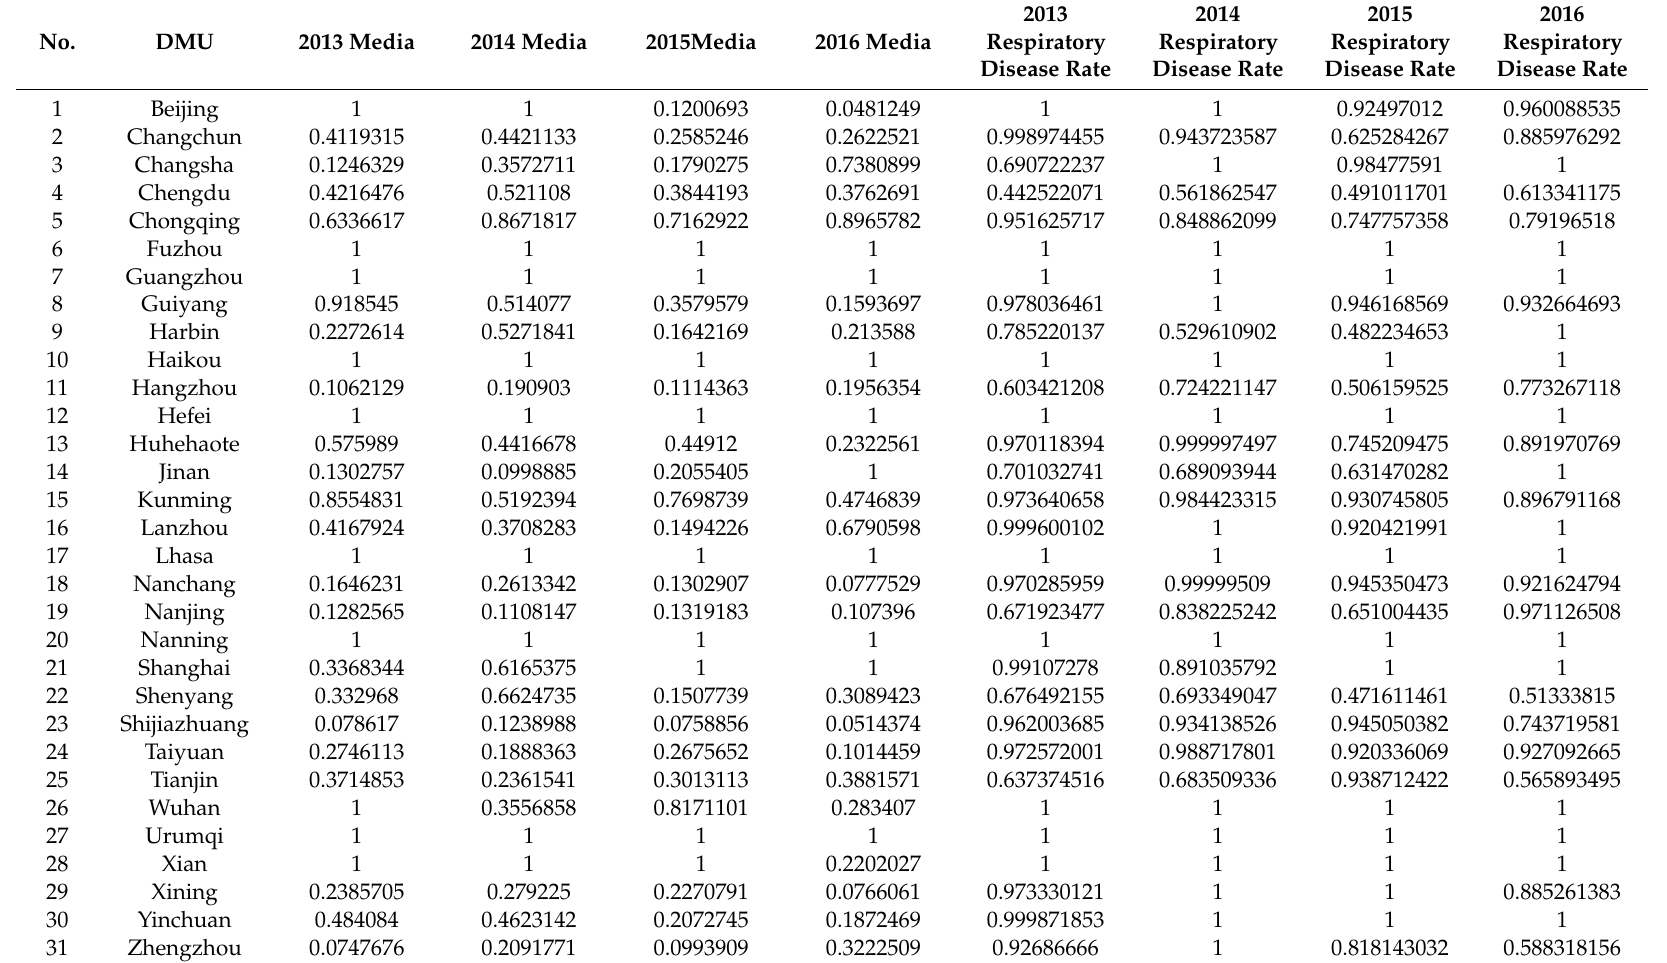
Table 7. Media Report and Respiratory Disease e ffi